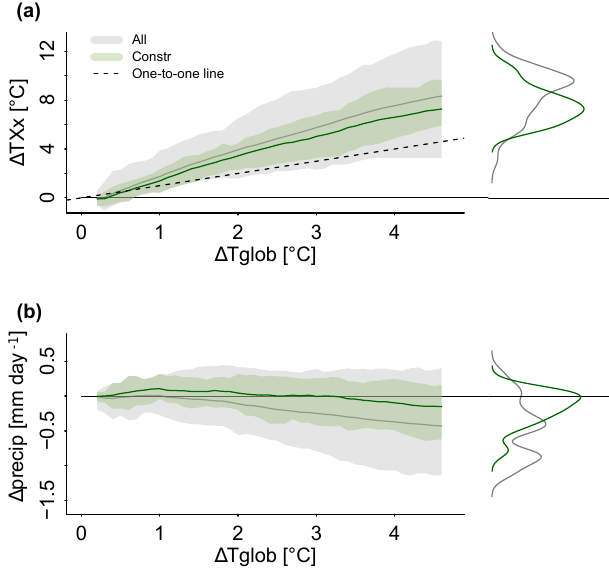
Figure A2. Changes in TXx and summer precipitation in CEU versus (cid:49)T glob . Changes are 20-year moving means starting from 1950–1969 to 2081–2100. The shaded area shows the minimum and maximum from the whole ensemble (grey) and the constrained en- semble